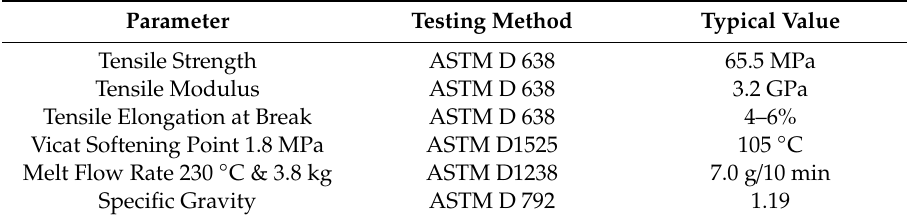
Table 1. Tensile properties as supplied by the